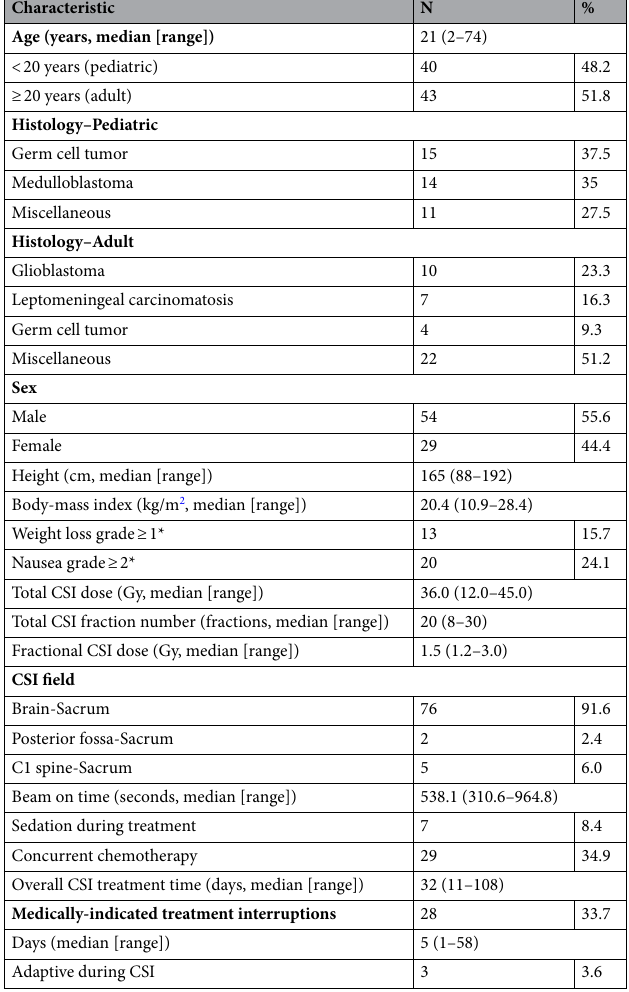
Table 1. Patient and treatment characteristics. CSI craniospinal irradiation; Gy gray. *Based on common terminology criteria for adverse events version